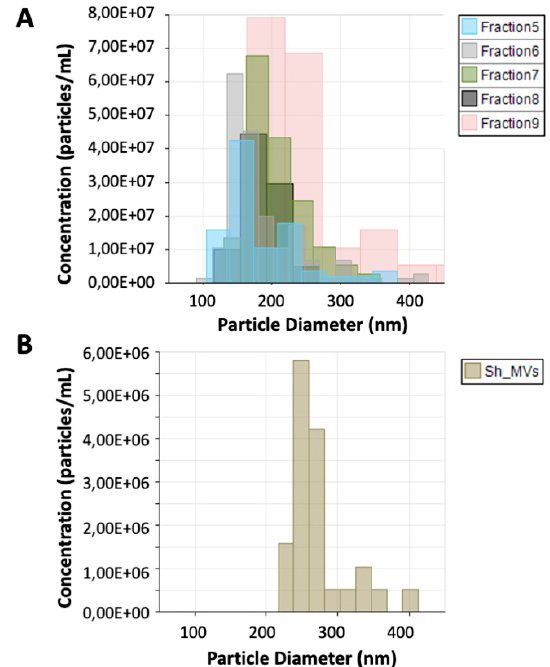
Figure 1. Tunable resistive pulse sensing analysis of 120k pellet vesicles and 15k pellet vesicles from Schistosoma haematobium . The size and number of extracellular vesicles (EVs) secreted by S. haematobium were analyzed by qNano (iZon). ( A ) Size and concentration of particles in fractions containing 120k pellet vesicles (5–9). ( B ) Size and particle concentration of S. haematobium 15k pellet